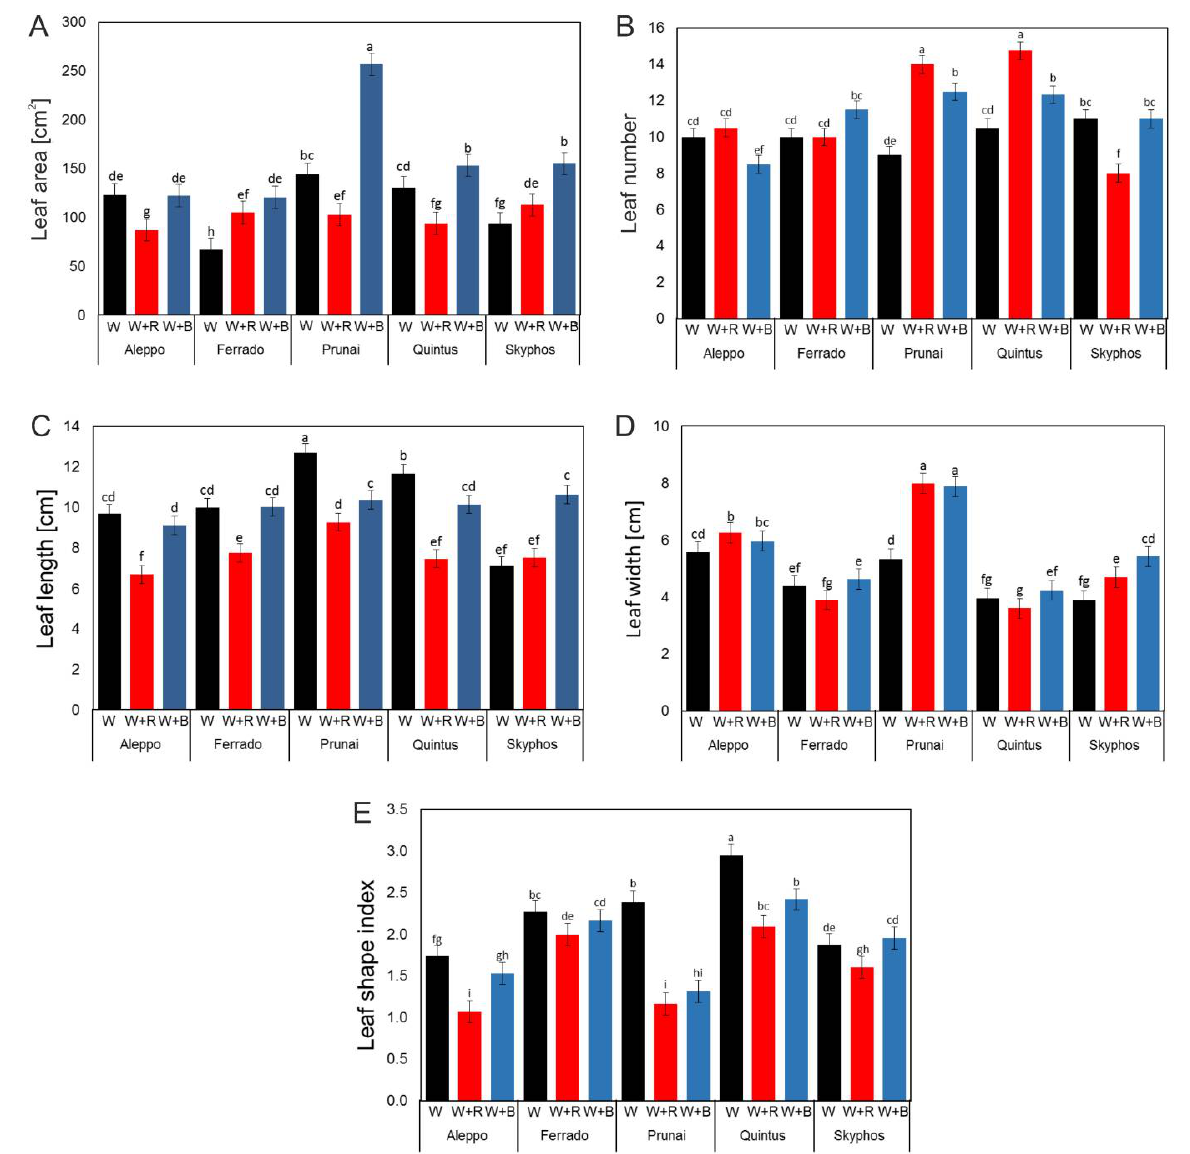
Figure 3. ( A–E ) The biometric parameters of leaf lettuce in the seedling stage grown under different light treatment (W—white light, W + R—white and red light, W + B—white and blue light). Different letters for the same parameter indicate significant differences at the 5% level, according to the Newman–Keuls’s test. The bars represent the standard deviation.